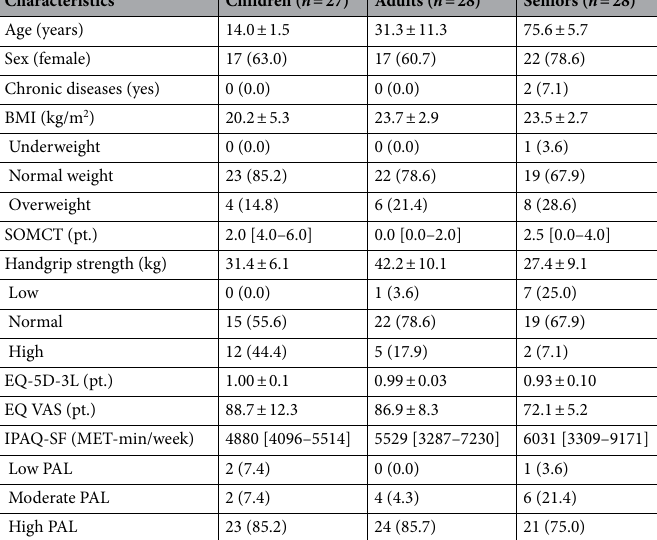
Table 1. Participant characteristics. Data given as n (%), median [interquartile range], or mean ± standard deviation. BMI body mass index, SOMCT Short Orientation-Memory-Concentration Test, EQ-5D-3L